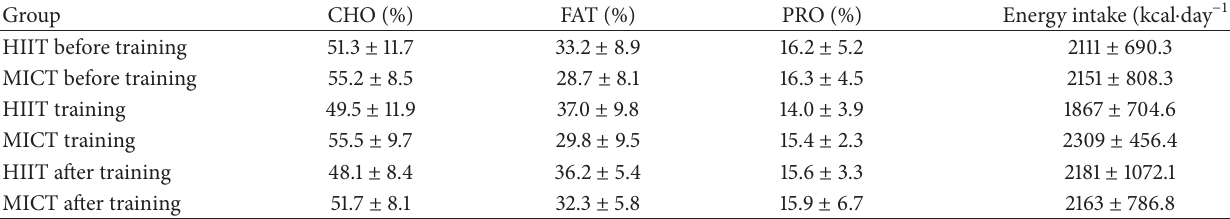
Table 3: Carbohydrate, fat, and protein levels before, during, and after